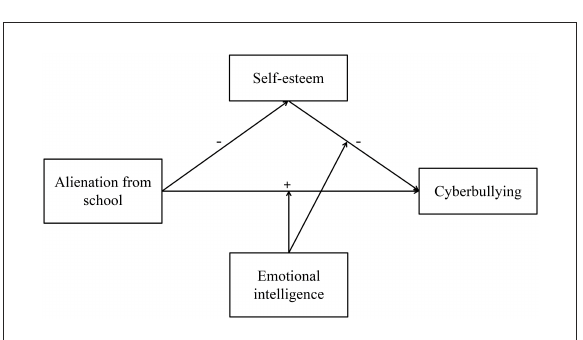
FIGURE2 Proposed mechanism of the association between alienation from school and